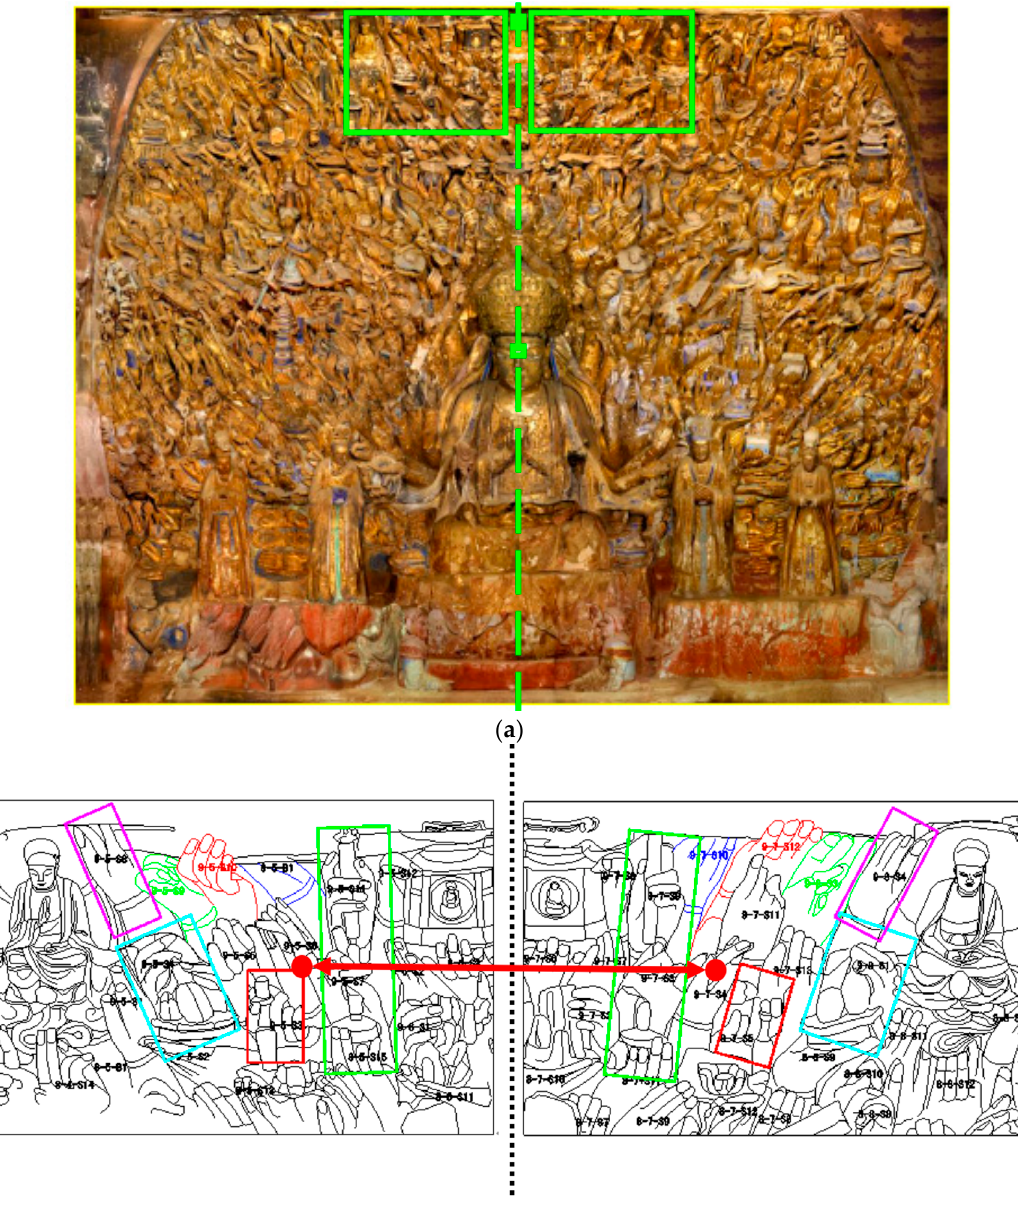
Figure 14. Characteristics of symmetry in the Dazu Thousand-Hand Bodhisattva statue: ( a ) space areas of hands 9-7-s4 (right side) and 9-5-s6 (left side); ( b ) local enlargement of line drawing with the geometrically similar hand.